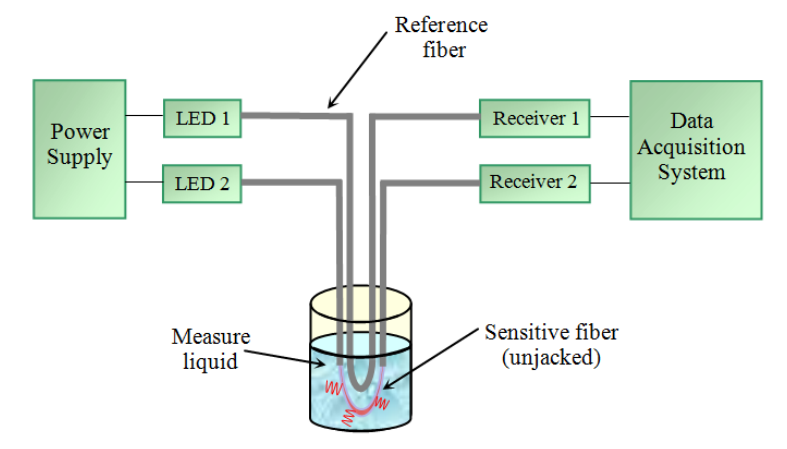
Figure 3. Diagram of the optical fiber